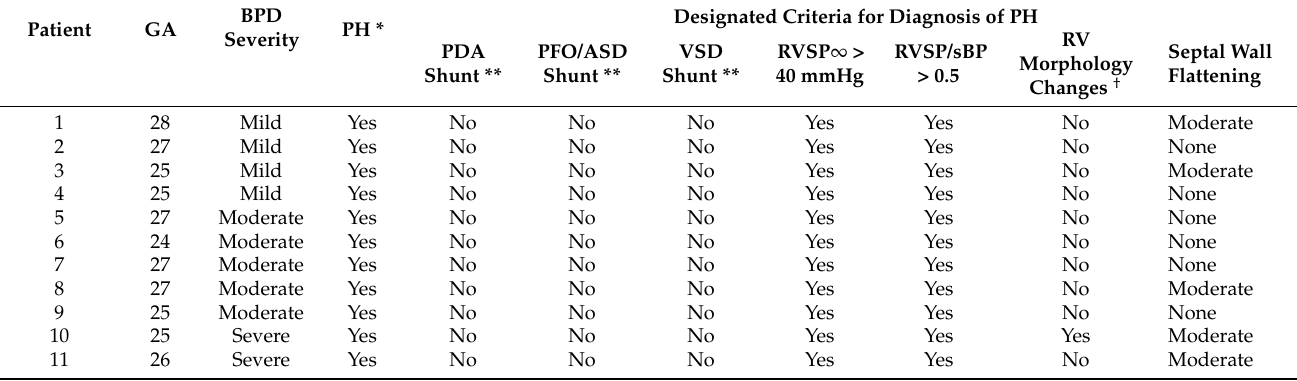
Table 2. Criteria for pulmonary hypertension diagnosis at 36 weeks postmenstrual